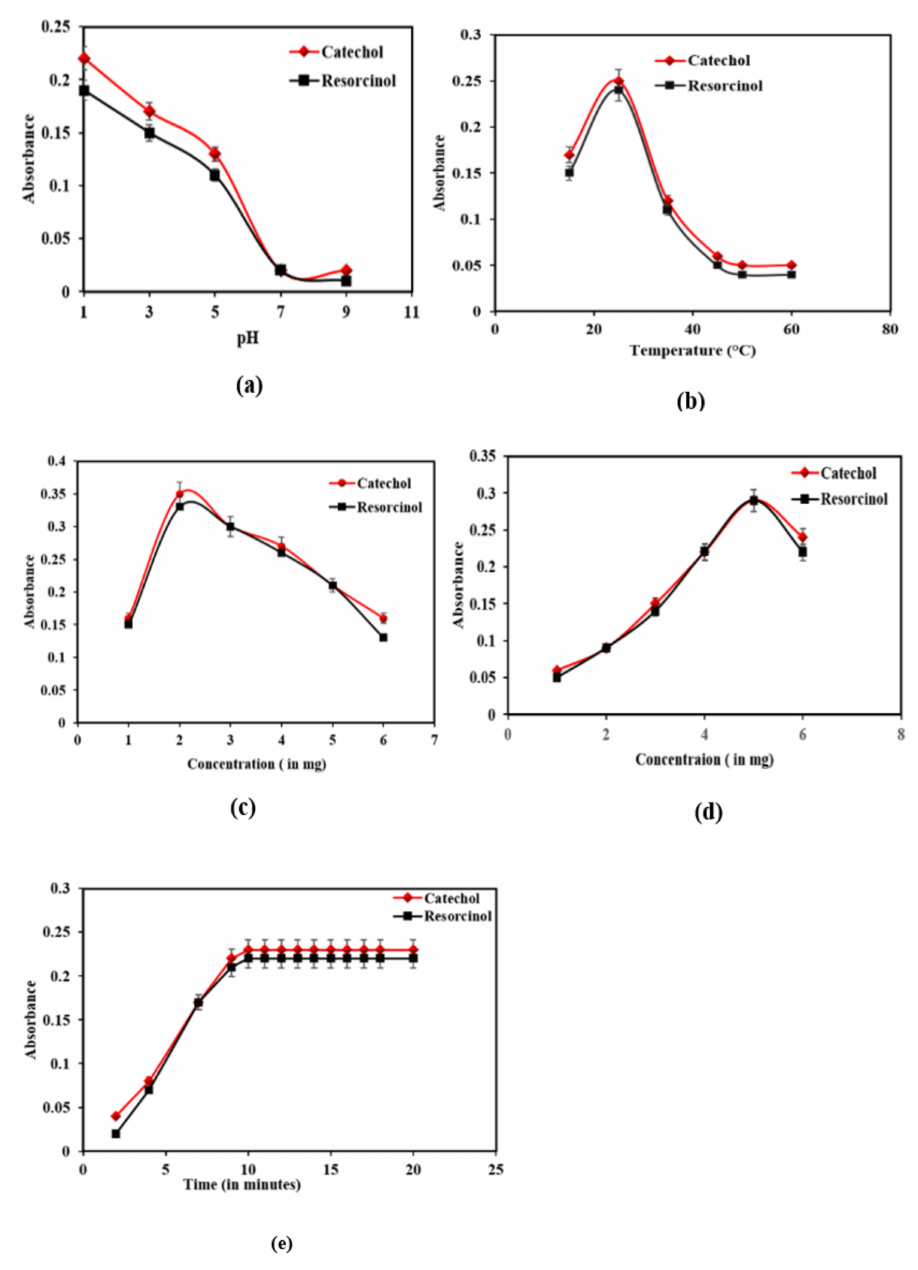
Figure 5. Factors affecting PPO-mimic activity ( a ) Effect of pH ( b ) Effect of temperature ( c ) Effect of substrate concentration ( d ) Effect of H-4 NPs concentration ( e ) Effect of contact time (pH = 3.0 at 25 ◦ C and 0.5 mL H 2 O 2